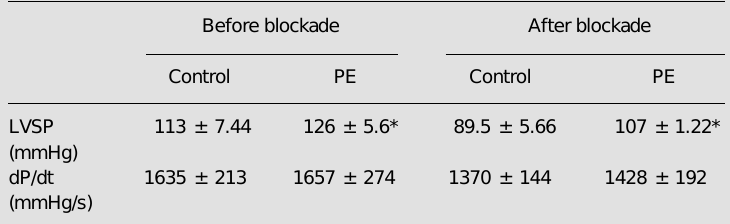
Table 1 - Effects of phenylephrine (PE) on left ventricular systolic pressure (LVSP) and rate of rise of pressure (dP/dt) in anesthetized rats before and after sympathetic and parasympathetic blockade with propranolol and